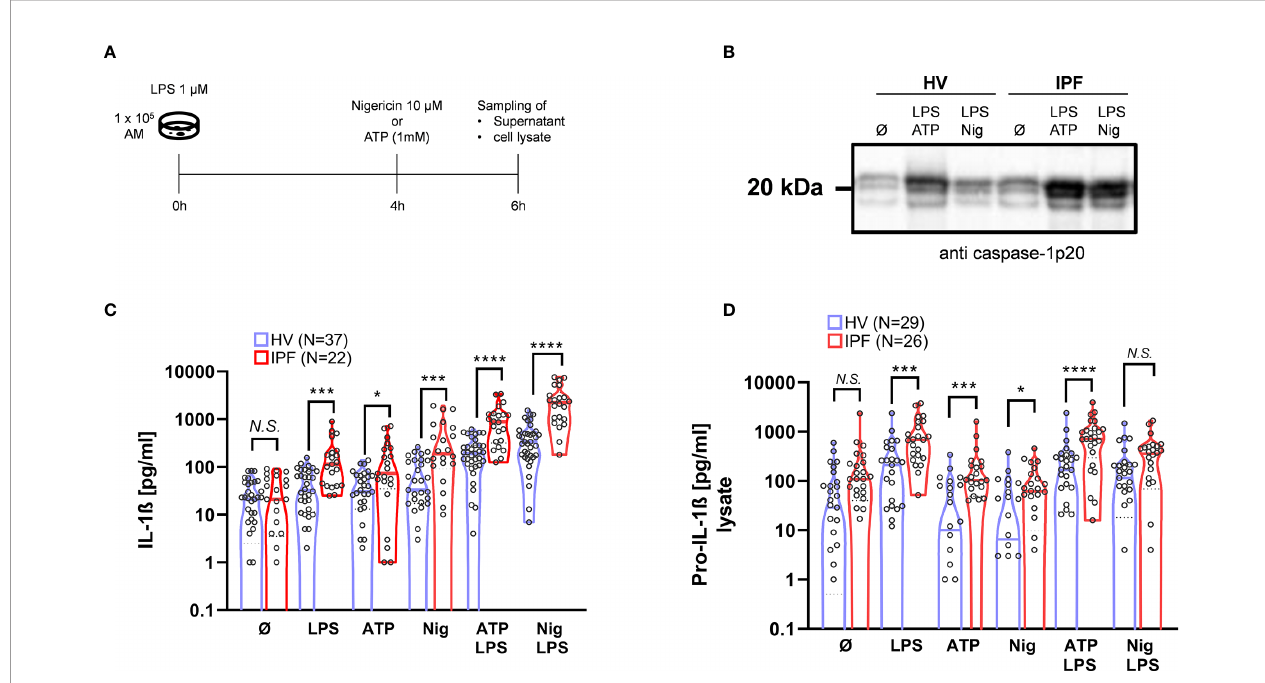
FIGURE 1 | The ability to activate the NLRP3 in fl ammasome is signi fi cantly increased in BAL cells from IPF patients. For NLRP3 stimulation, bronchoalveolar lavage (BAL) cells were incubated and stimulated with LPS at 0h, following Nigericin or ATP stimulation after 4h (A) . In both healthy volunteers (HVs) and idiopathic pulmonary fi brosis (IPF) there was a signi fi cant increase in IL-1ß production following NLRP3-in fl ammasome stimulation protocol (B) , with signi fi cant higher responses in IPF compared to HV. Caspase-1 activation is demonstrated by representative immunoblotting of cleaved caspase-1p20 (representative blot shown; total of n = 15 immunoblots performed). (C) . Pro-IL-1ß concentration in cell lysates was elevated in IPF patients compared to HV following stimulation with LPS, ATP, Nigericin, and LPS + ATP (D) . IL-1ß and Pro-IL-1ß values were compared using unpaired t-tests; *p < 0.05; ***p < 0.001; ****p < 0.0001, N.S . non-signi fi